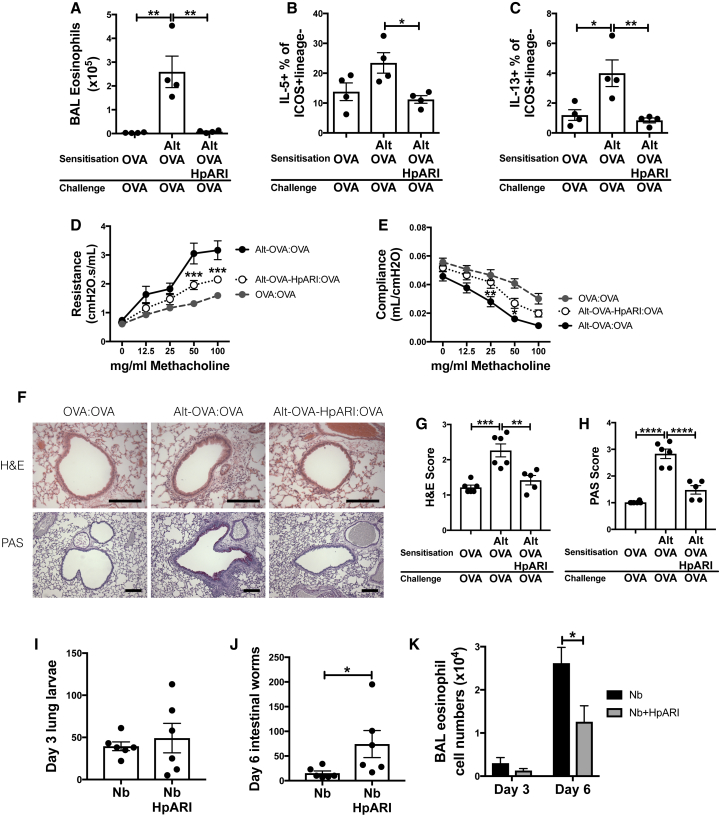
HpARI Suppresses Responses to Alternaria Allergen(A) Day 17 BAL eosinophil numbers after Alternaria allergen, OVA protein, and HpARI administration on day 0 (sensitization), and OVA protein alone on days 14, 15, and 16 (challenge).(B) Lung ILC2 IL-5 production from mice in (A).(C) Lung ILC2 IL-13 production from mice in (A).(D) Lung resistance in methacholine challenge from mice treated as in (A).(E) Lung compliance in methacholine challenge from mice treated as in (A).(F) H&E- (top panels) and PAS-stained (bottom panels) lung sections from mice treated as in (A). Scale bars indicate 100 μm.(G) H&E scoring of sections from mice treated as in (A).(H) PAS scoring of sections from mice treated as in (A).Alternaria model data representative of 2–3 repeat experiments, each with 4–6 mice per group.(I) Mice were subcutaneously infected with N. brasiliensis, and HpARI administered intranasally on days 0, 1, and 2 of infection. Lung larvae were counted 3 days after infection.(J) Day 6 intestinal N. brasiliensis worms from mice treated as in (I).(K) Day 3 and day 6 BAL eosinophil numbers from mice treated as in (I).Error bars show SEM.